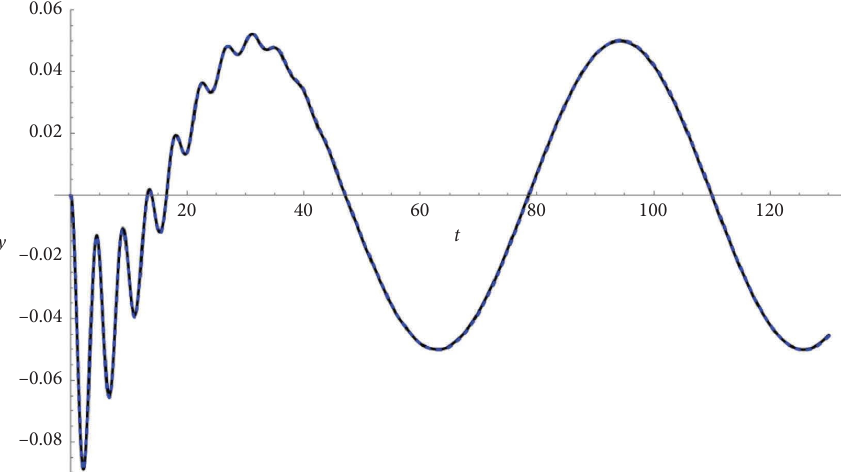
Figure 5: Imaginary part compared with the Runge–Kutta numerical solution.